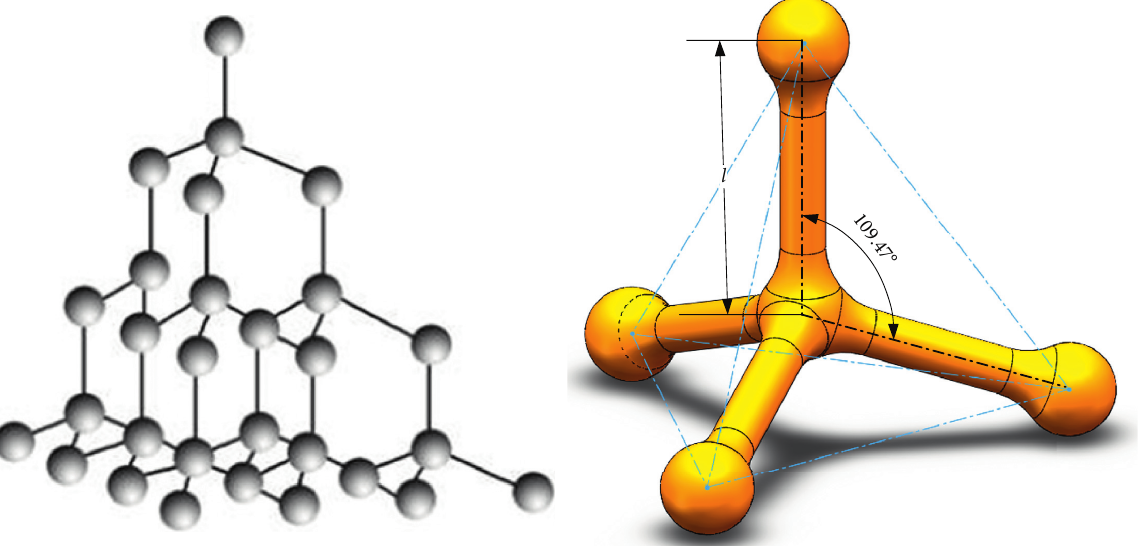
Figure 2: The diamond lattice structure unit.